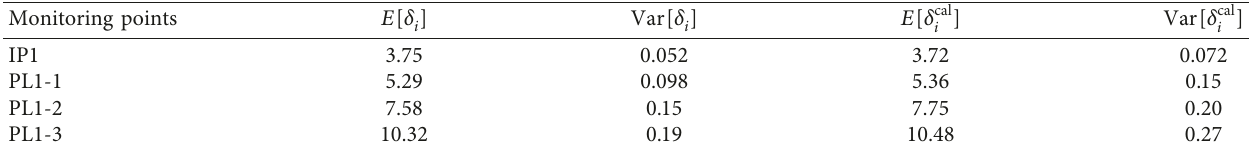
Table 5: Comparison between the predicted displacement and the measured data.